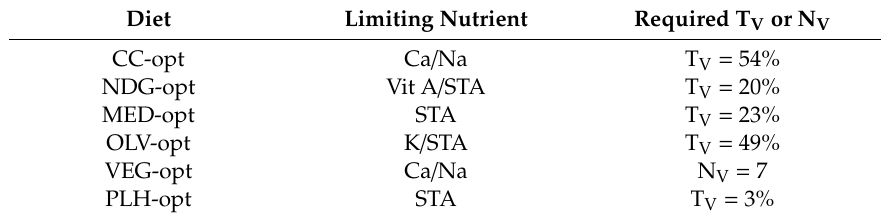
Table 4. Minimal acceptability variation limits required for each diet to fulfill the nutritional